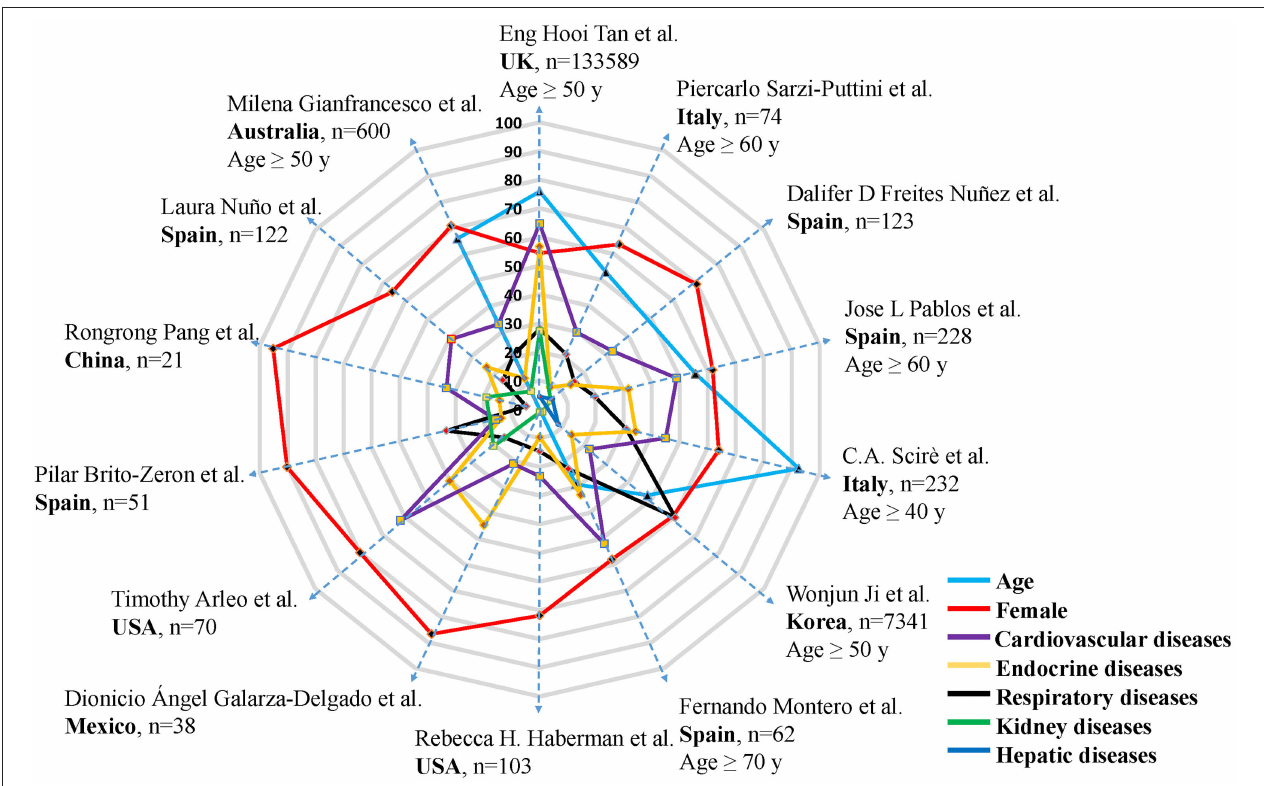
FIGURE 2 | Ratio of female, elder patients, and comorbidity in RADs patients with COVID-19. A total of 14 articles were illustrated. Authors, country, sample size, different cut-off points of age were detailed in the figure. Each dotted blue line with arrows connects indicators from the same study, each dot represents one study, age (study n = 7), female (study n = 14), comorbidity (study n = 14). Different colors represent corresponding parameters, n represents the number of RADs patients infected with COVID-19. Each layer (gray line) on the radar map represents 10 percent.